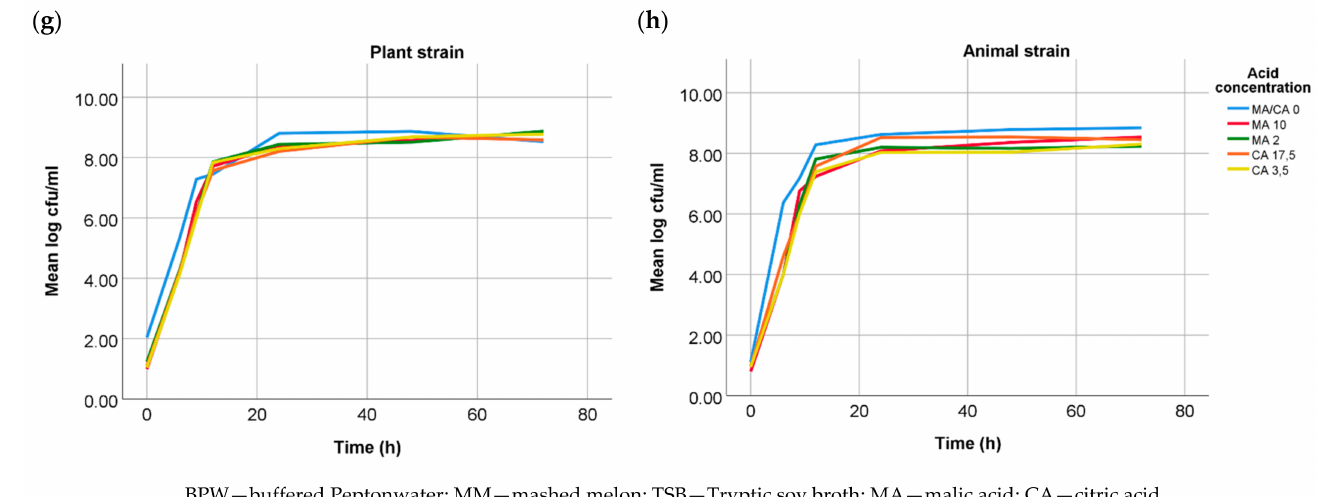
Figure 1. Growth curves of both Salmonella Choleraesuis strains under different conditions: growth in BPW, TSB and MM at 5, 22 and 37 ◦ C of the plant ( a ) and the animal ( b ) strain; growth at different pH values in BPW at 37 ◦ C of the plant, where differences at pH 5.5 were significant (*) with a p -value of 0.030 ( c ), and the animal strain ( d ); growth in addition of different sugars of the plant ( e ) and the animal ( f ) strain; and growth at different concentrations of malic and citric acid of the plant ( g ) and the animal ( h ) strain.